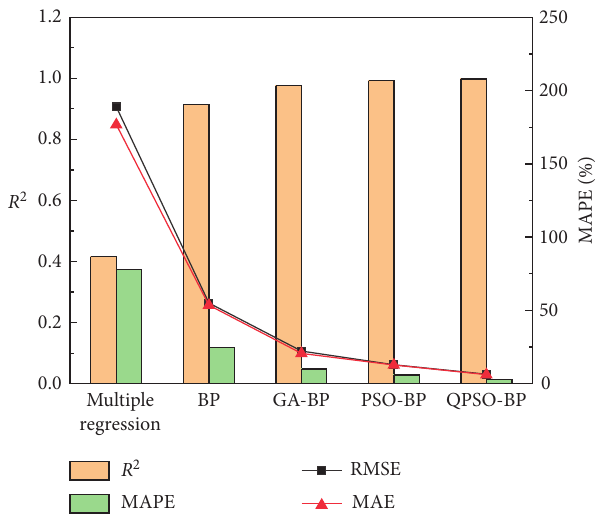
Figure 6: Error analysis results of the different calculation